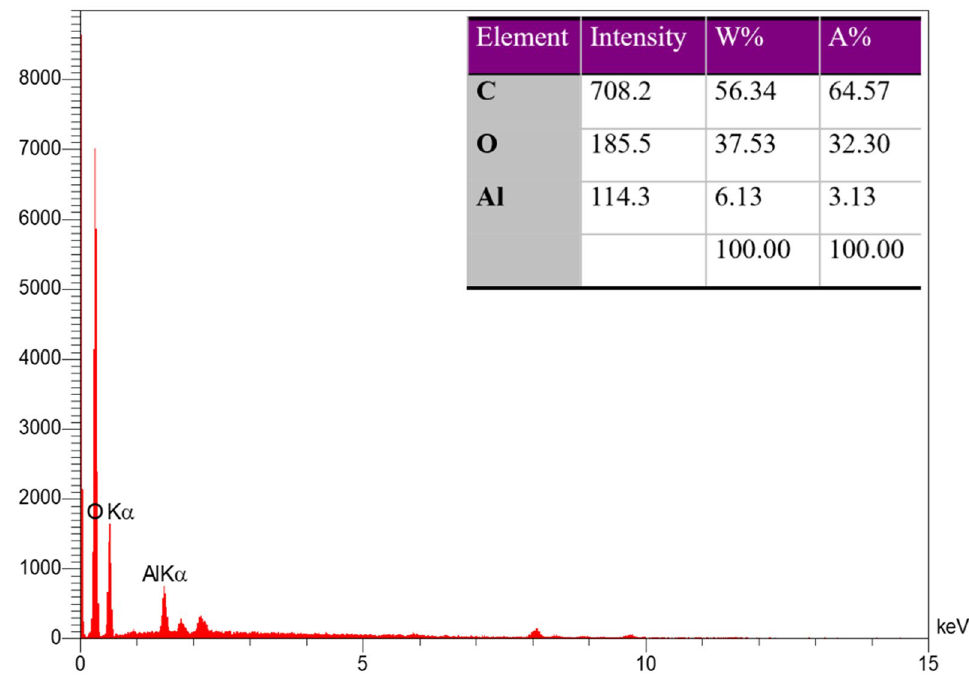
Figure 3. Elemental analysis plot and data.